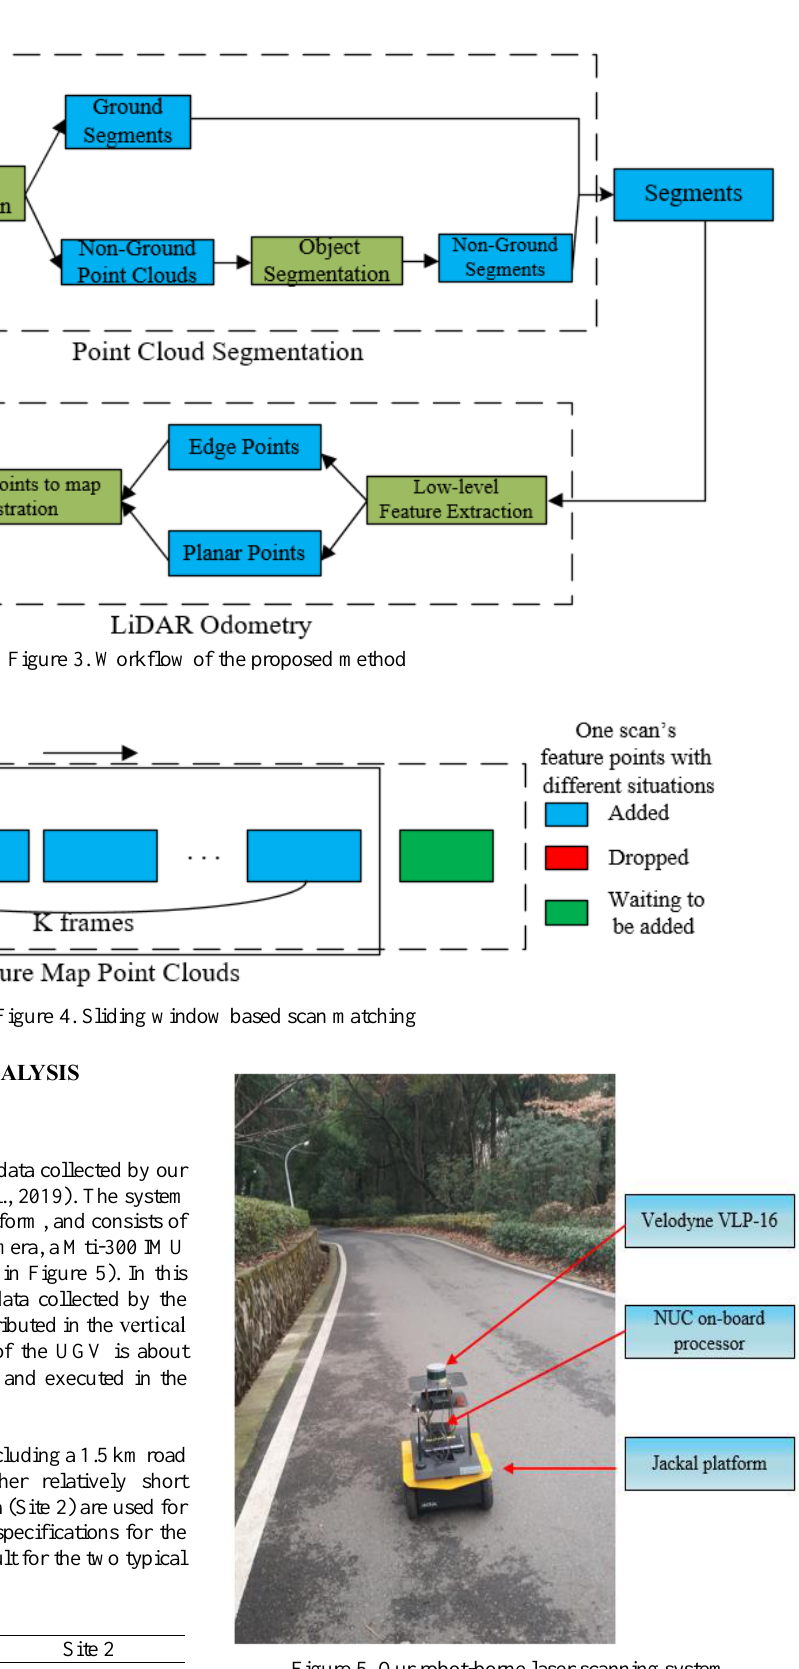
Figure 5. Our robot-borne laser scanning system